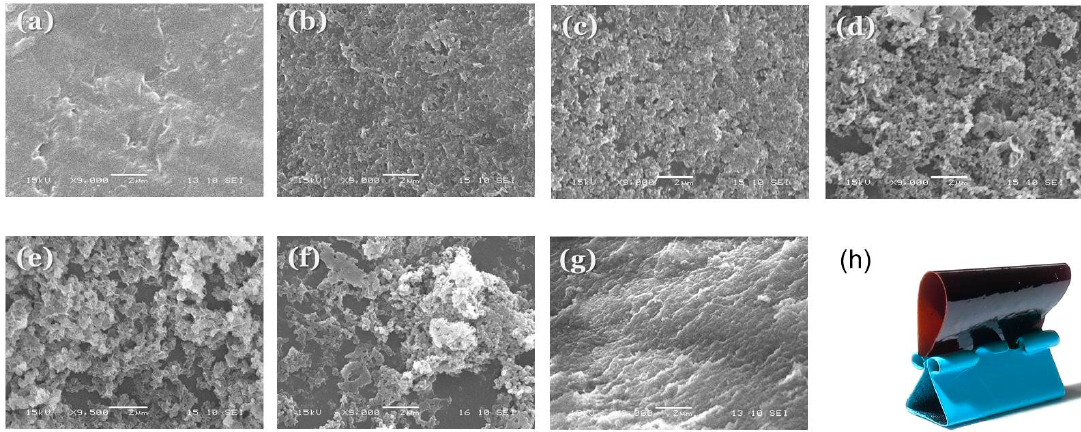
Figure 10. ( a – g ) Scanning electron microscope (SEM) images of epoxy–benzoxazine/PEO- b -PCL blends: ( a ) 100/0, ( b ) 95/5, ( c ) 90/10, ( d ) 80/20, ( e ) 70/30, ( f ) 60/40, ( g ) 50/50. ( h ) Photograph of a corresponding thin film (composition: 70/30).